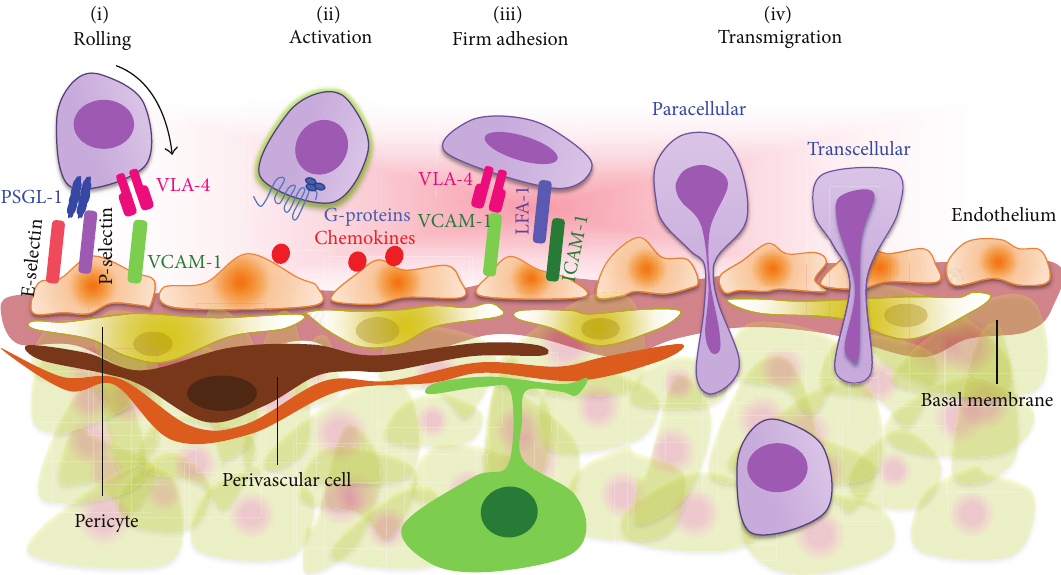
Figure 1: Leukocyte extravasation cascade. Leukocytes initially engage with the endothelium via selectin and VCAM-1 mediating interactions duringrolling(i),followedbyG-protein-mediatedactivation(ii)andsubsequentintegrin-mediatedfirmadhesion(iii).Transmigrationacross theBBBmayoccurviaparacellularortranscellularroutes(iv). ItremainstobedeterminedwhethersystemicallyinfusedMSCspossesssimilar or distinct features and mechanisms enabling them to transmigrate across the BBB and home to the CNS system in vivo .